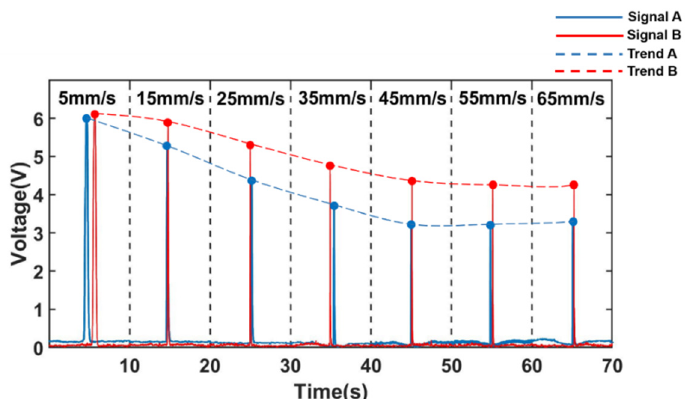
Figure 16. Signal change of ferromagnetic metal particles (350 μ m Fe) with velocity change after adjusting the detection circuit.